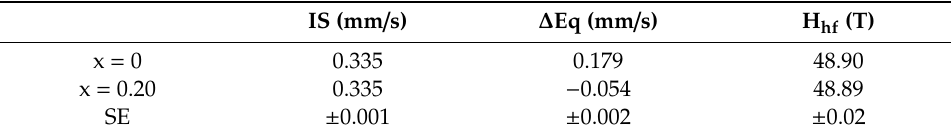
Table 4. Mössbauer parameters for x = 0 and x = 0.20